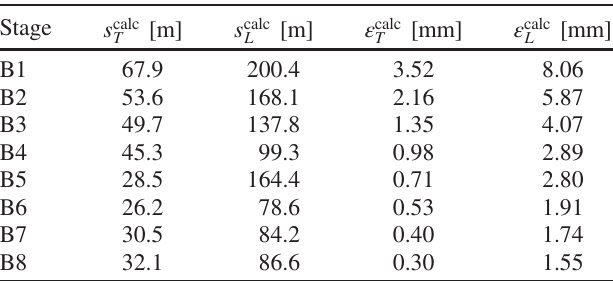
TABLE III. Performance of a 6D rectilinear channel after bunch recombination based on theory. Emittances are calculated from Eq. (9) while the cooling lengths s calc are calculated from Eqs. (10) and (11). The error between theory and simulation (from Table II) is less than 18%. The theoretical numbers are based on using the initial values in each stage that were obtained from the simulation of the previous